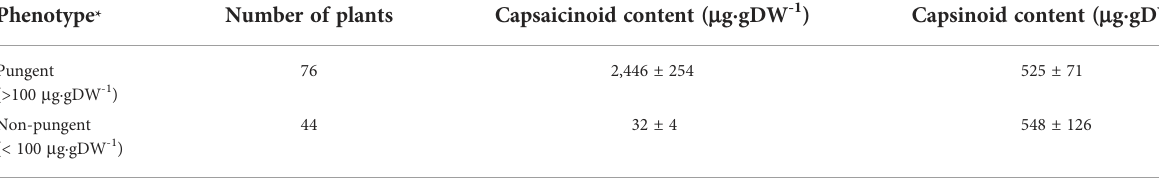
TABLE 2 The total capsaicinoid and capsinoid contents in the ‘ PJ ’ F 2